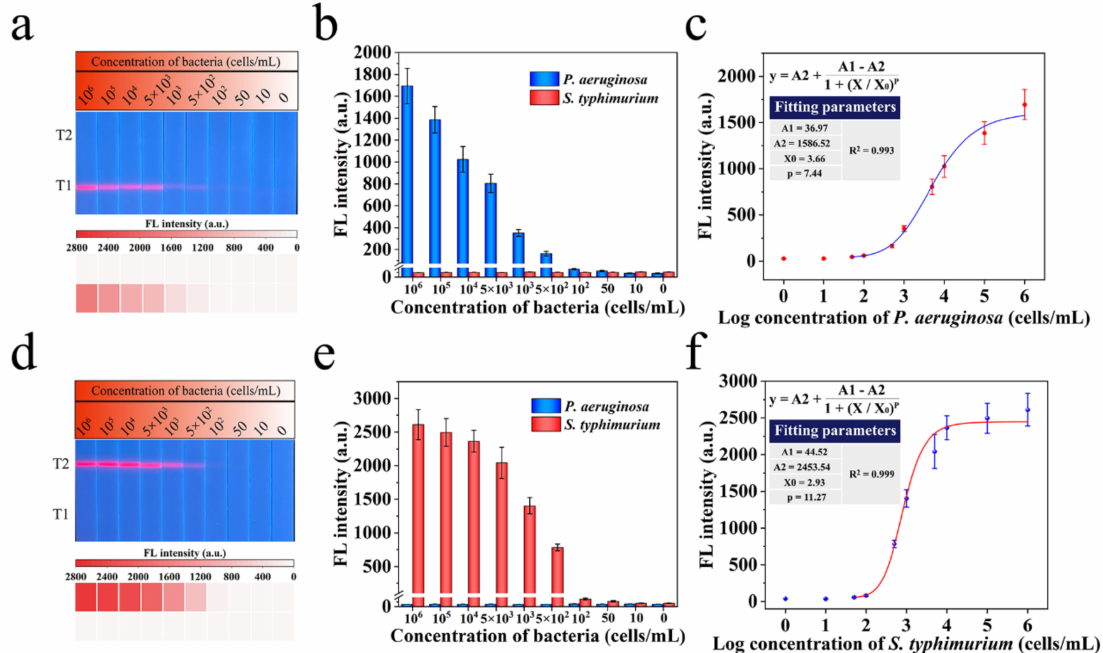
Figure 4. Fluorescence pictures and heat maps of test lines for LFA strips for P. aeruginosa ( a ) and S. typhimurium ( d ). T1 and T2 mean test lines for P. aeruginosa and S. typhimurium , respectively. Corresponding fluorescence intensity of the test lines for P. aeruginosa ( b ) and S. typhimurium ( e ). Corresponding calibration lines of P. aeruginosa ( c ) and S. typhimurium ( f